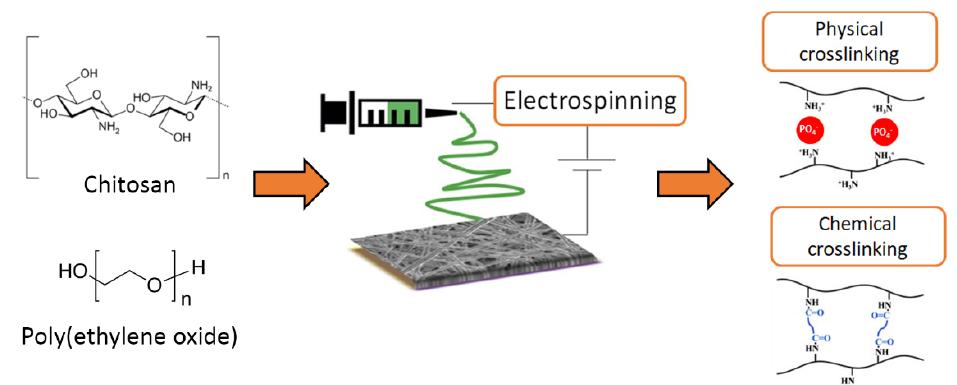
Figure 2. Schematic of the fabrication procedure of chitosan-based membranes.